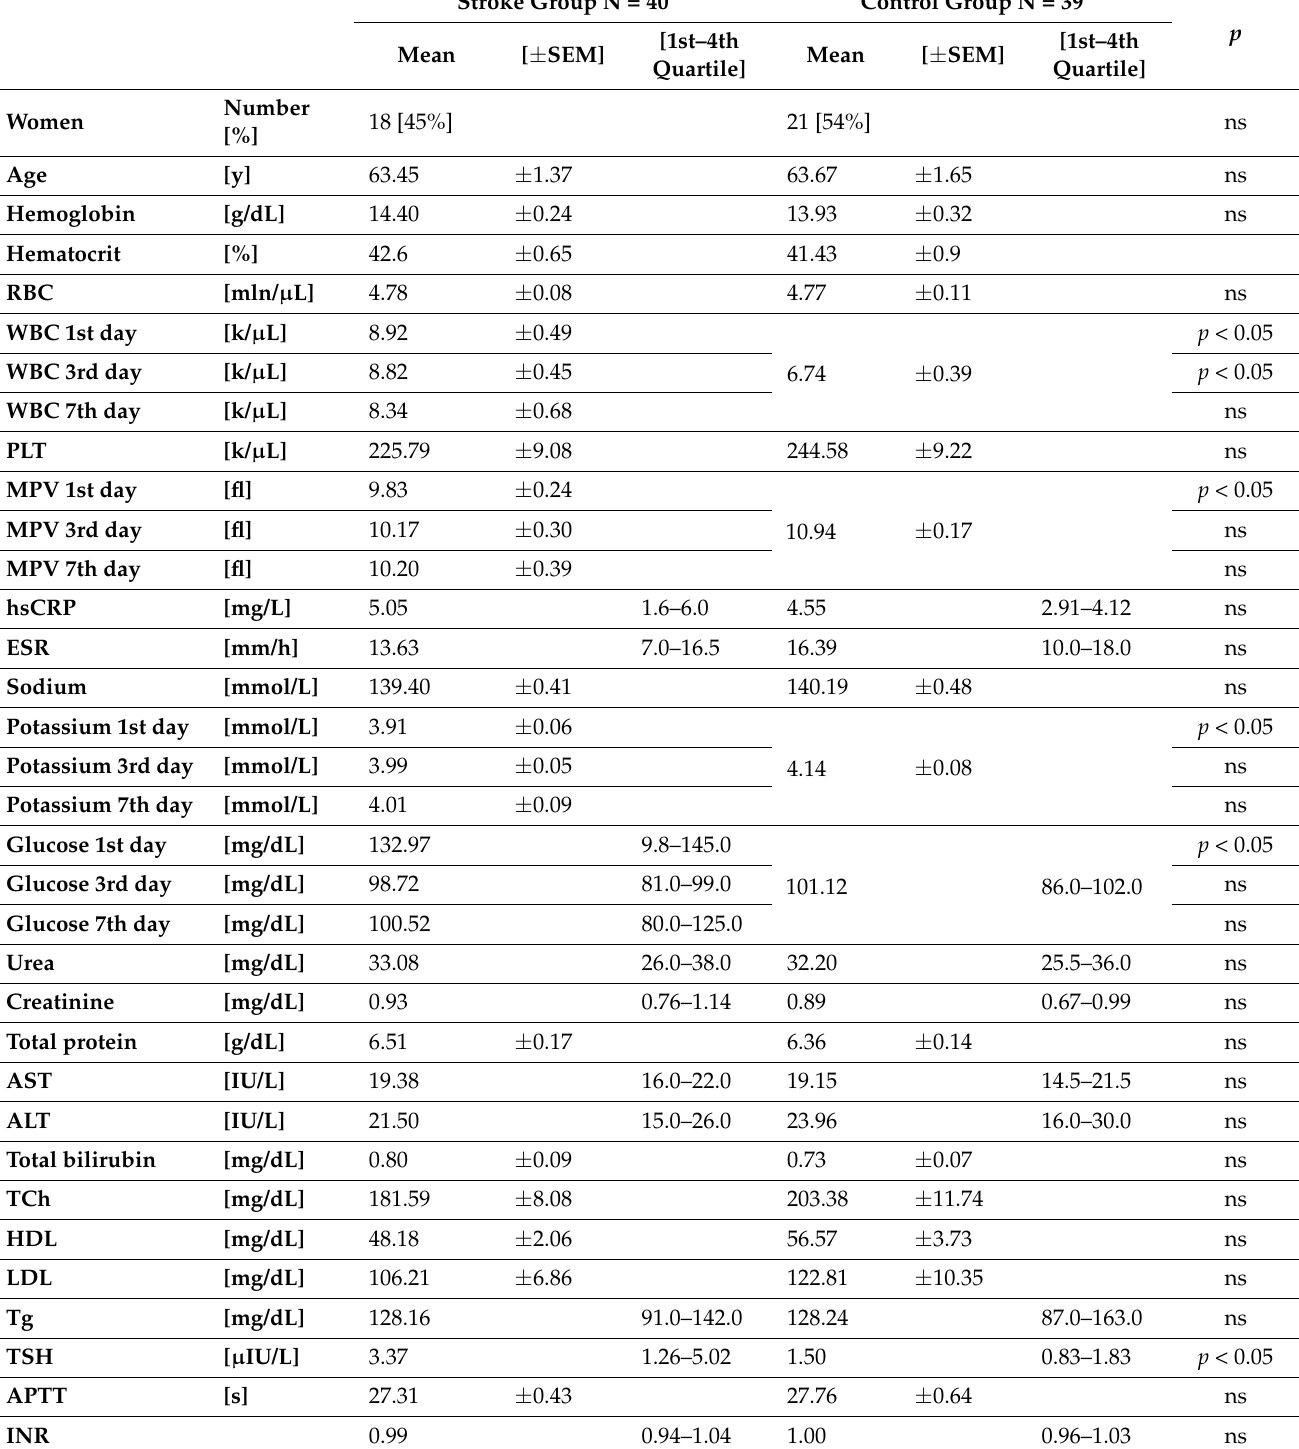
Table 1. Demographic and biochemical characteristics between studied groups including cardio- vascular risk stratification parameters. Results are presented as mean ± SEM if the distribution of variables were normal or median with 1st and 4th quartile if the distribution of variables were not